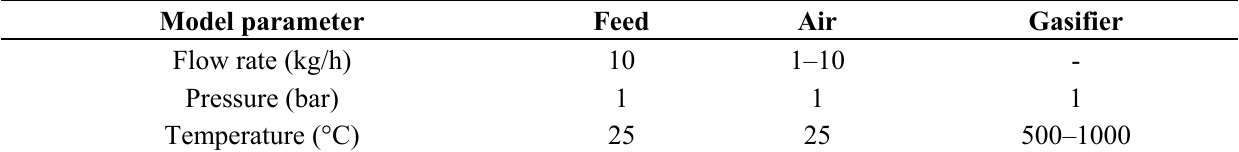
Table 2. Gasification operating parameters for different